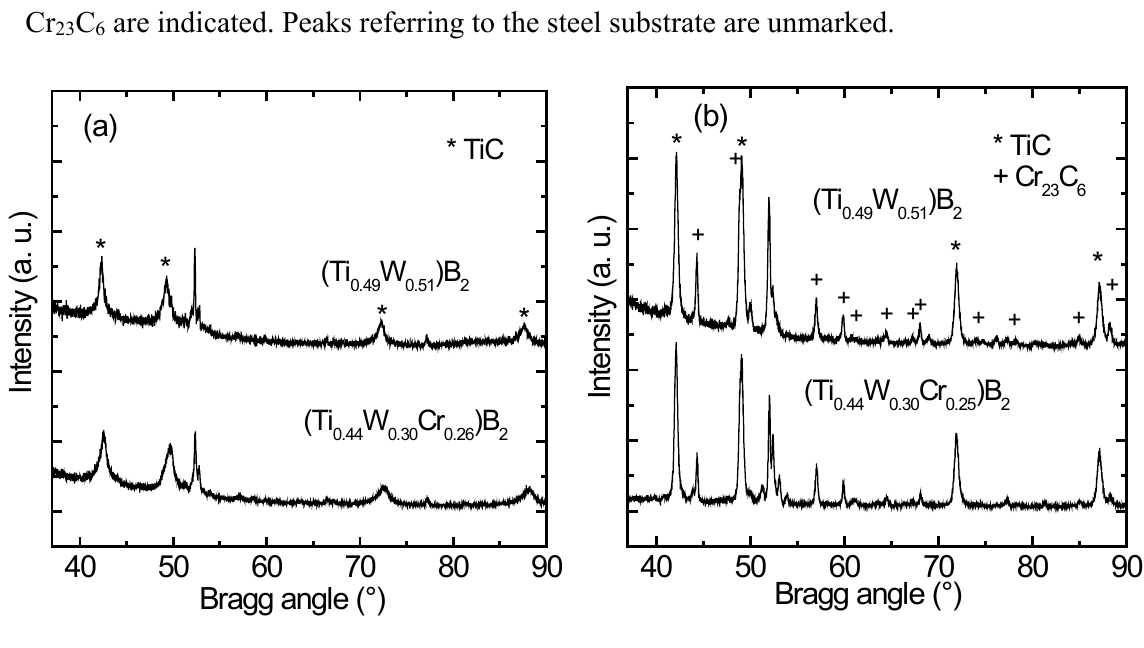
W )B and (Ti W Cr )B coatings after 0.49 0.51 2 0.44 0.30 0.26 2